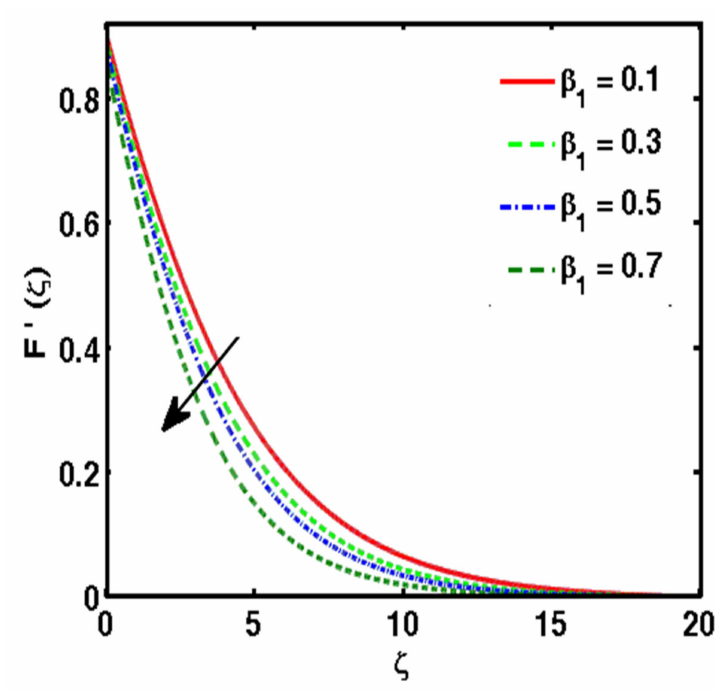
Figure 3. Variation of β 1 and F (cid:48) ( ζ ) .